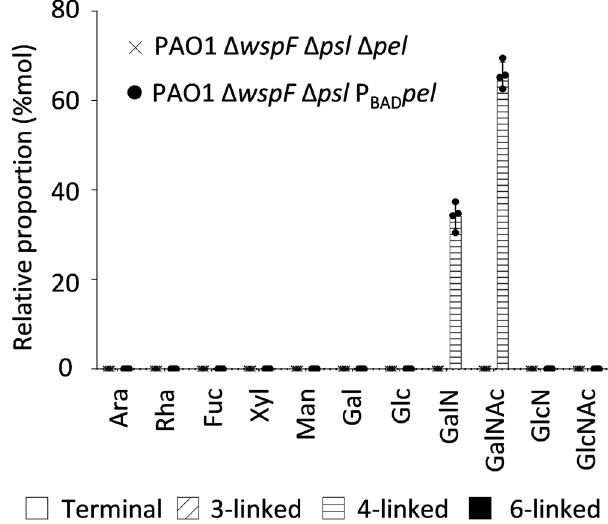
diagonal dash: 3-linked residues, horizontal dash: 4-linked residues, black fi lled: 6-linked residues). Ara arabinose, Rha rhamnose, Fuc fucose, Xyl xylose, Man mannose, Gal galactose, Glc glucose, GalN galactosamine, GalNAc N -acetylgalactosamine, GlcN glucosamine, GlcNAc N -acetylglucosamine ” . The Figure Legend should read: “ Fig. 1 Pel is a partially de-N-acetylated polymer of 1,4-Nacetylgalactosamine. Monosaccharide composition and linkage analysis of Pel by GC-MS. Average and standard deviation of four biological replicates are represented. Histogram patterns represent the linkage found in the PMAA derivatization (no pattern: terminal residues, diagonal dash: 3-linked residues, horizontal dash: 4-linked residues, black fi lled: 6-linked residues). Ara arabinose, Rha rhamnose, Fuc fucose, Xyl xylose, Man mannose, Gal galactose, Glc glucose, GalNAc N -acetylgalactosamine, GalN galactosamine, GlcN glucosamine, GlcNAc N - acetylglucosamine ”